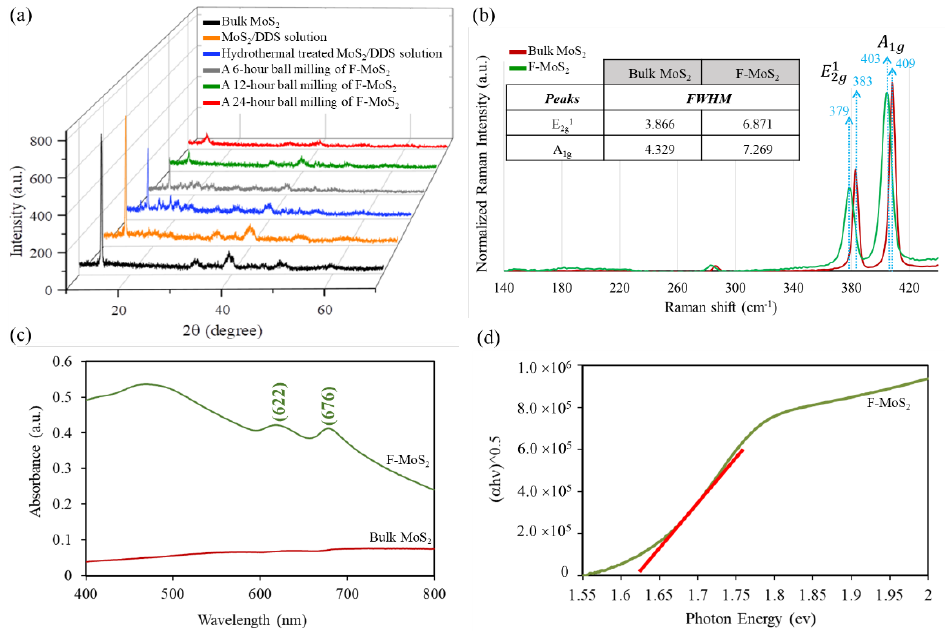
Figure 7. ( a ) XRD patterns, ( b ) Raman spectra and ( c , d ) UV-Vis absorption spectra and bandgap calculation of various samples.